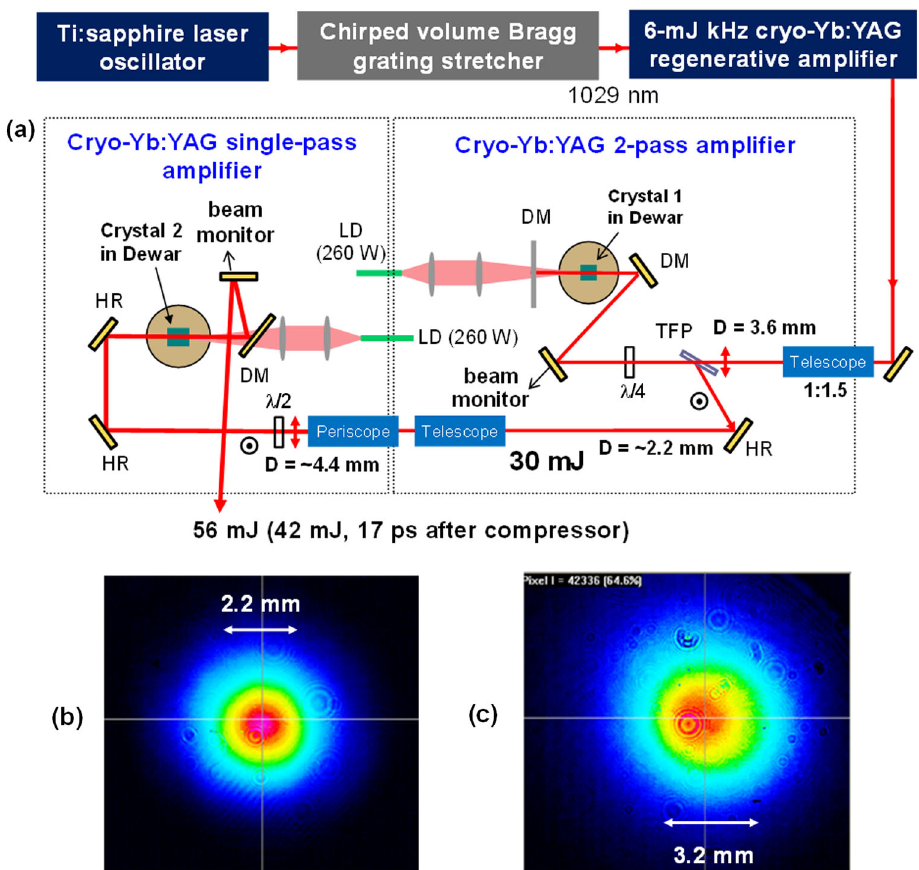
FIG. 14. Optical layout of the three-stage kHz picosecond cryogenic Yb ∶ YAG CPA laser (a) and the beam profiles from the two-pass (b) and the single-pass amplifiers (c) [26]. The circular fringes in the beam profiles are the measurement artifact from neutral density filters. Crystal 1, 1% doped, 10-mm-long Yb ∶ YAG; Crystal 2, 2% doped, 20-mm-long, Yb ∶ YAG; D, diameter; HR, high reflector; DM, dichroic mirror; TFP, thin-film polarizer; λ = 2 , half wave plate; λ = 4 , quarter wave plate; LD, laser diode at 940